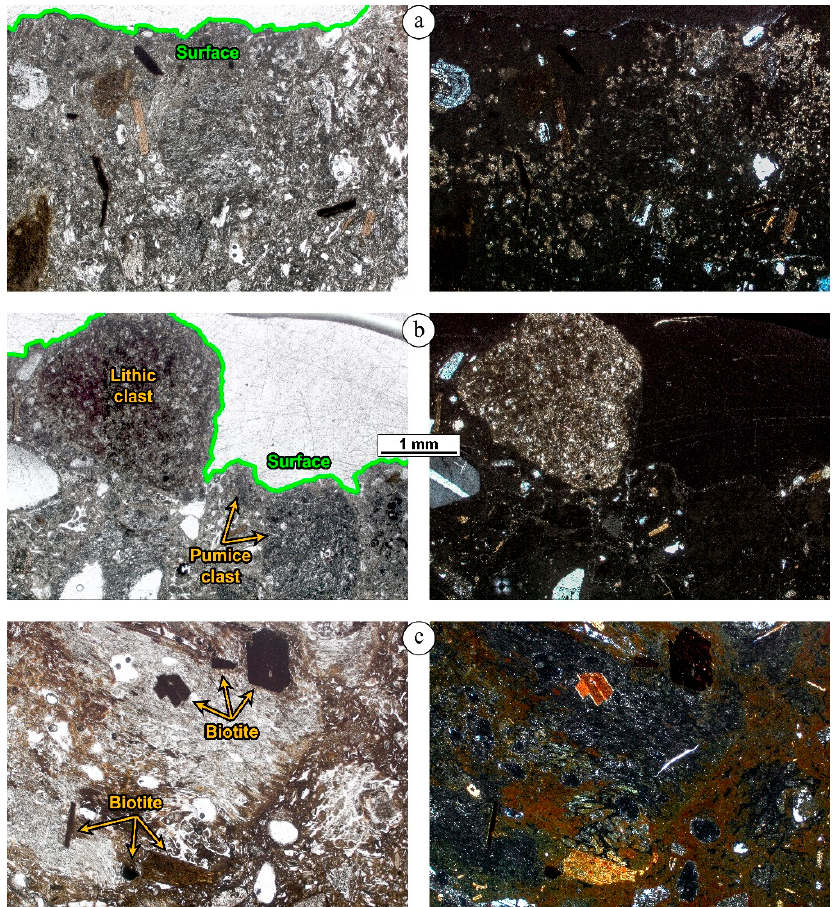
Figure 6. Photomicrographs in plane- and cross-polarized light of cross sections, at the same magnification, showing different weathering patterns: ( a ) near-surface alteration and devitrification of the glassy matrix, visible in the birefringent areas (Sirok Castle); ( b ) irregular surface morphology caused by differential erosion (Eger Castle, historical walls); ( c ) dispersion of brownish Fe oxides and hydroxides around biotites, in the matrix, and in the outer pores of pumice clasts (Sirok Castle).